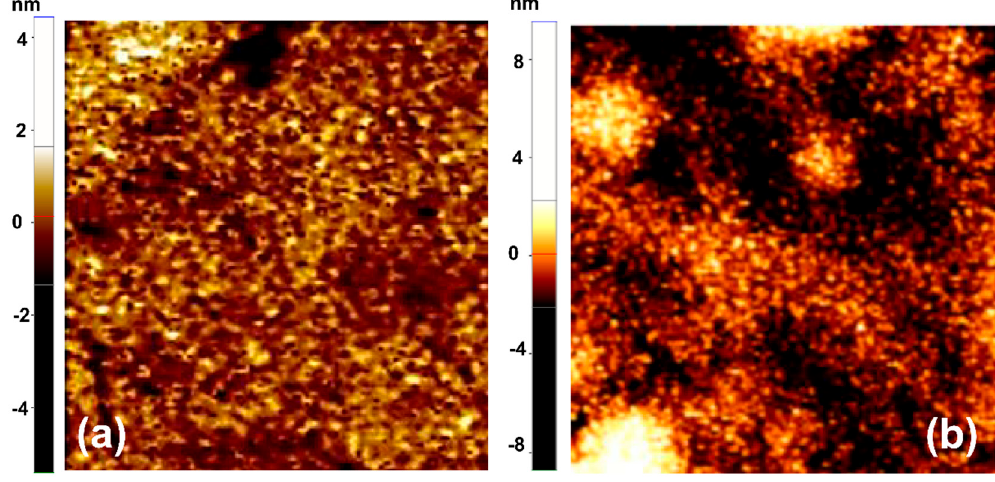
Figure 7. Atomic force microscope (AFM) images of ( a ) 5 nm and ( b ) 10 nm thick AlGaN surface scanned over 1 μ m × 1 μ m.